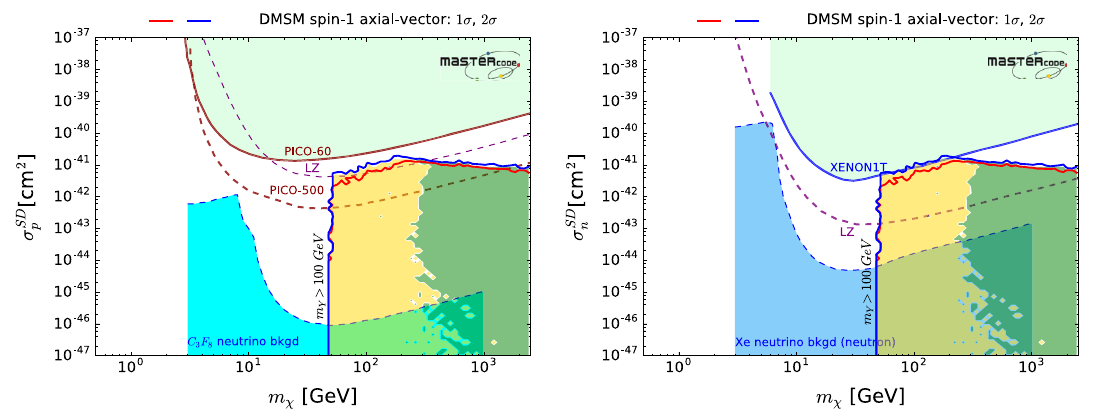
Fig. 13 Predictions for σ SD p and σ SD n in the DMSM with axial cou- plings. Left panel: Contours of the likelihood function in the ( m χ ,σ SD p ) plane for the axial-vector model, showing the rescaled upper limit from the PICO-60 experiment [79] and the prospective sensitivity of the PICO-500 [106] and LZ [100] experiments to σ SD p , as well as the neu-